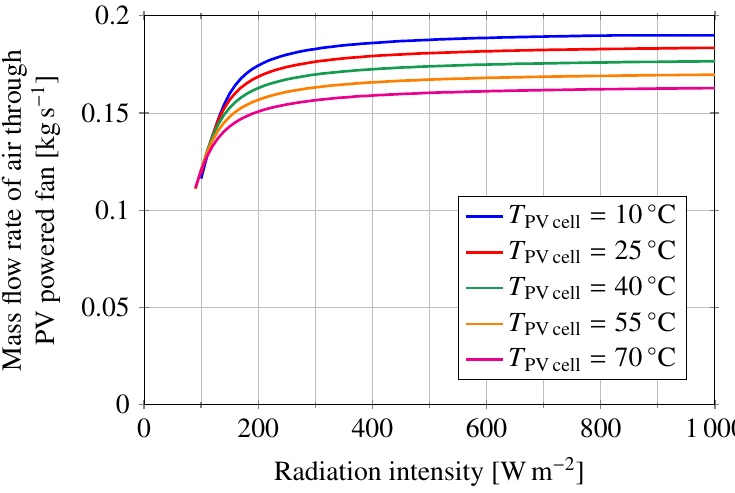
Figure 6. Mass flow rate of the PV-powered fan for various solar cell